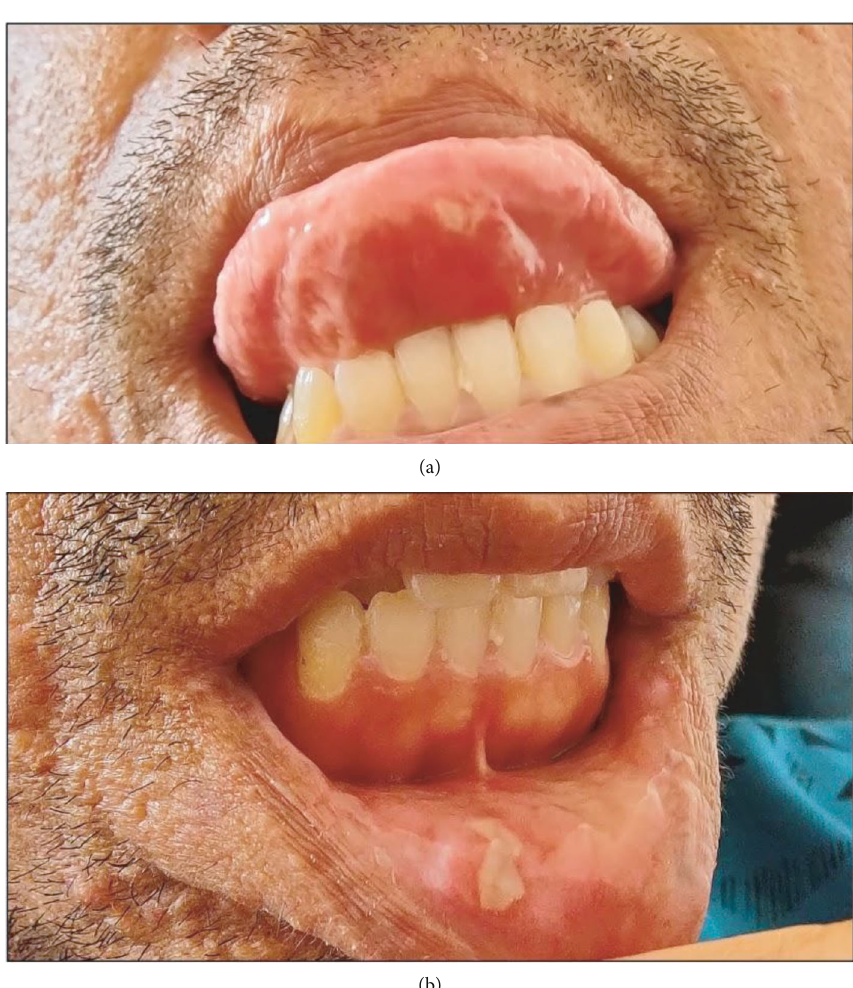
Figure 1: Photographs of the patient. Photographs of the patient ’ s oral mucosa demonstrating aphthous ulcers of the tongue (a) and the lower lip